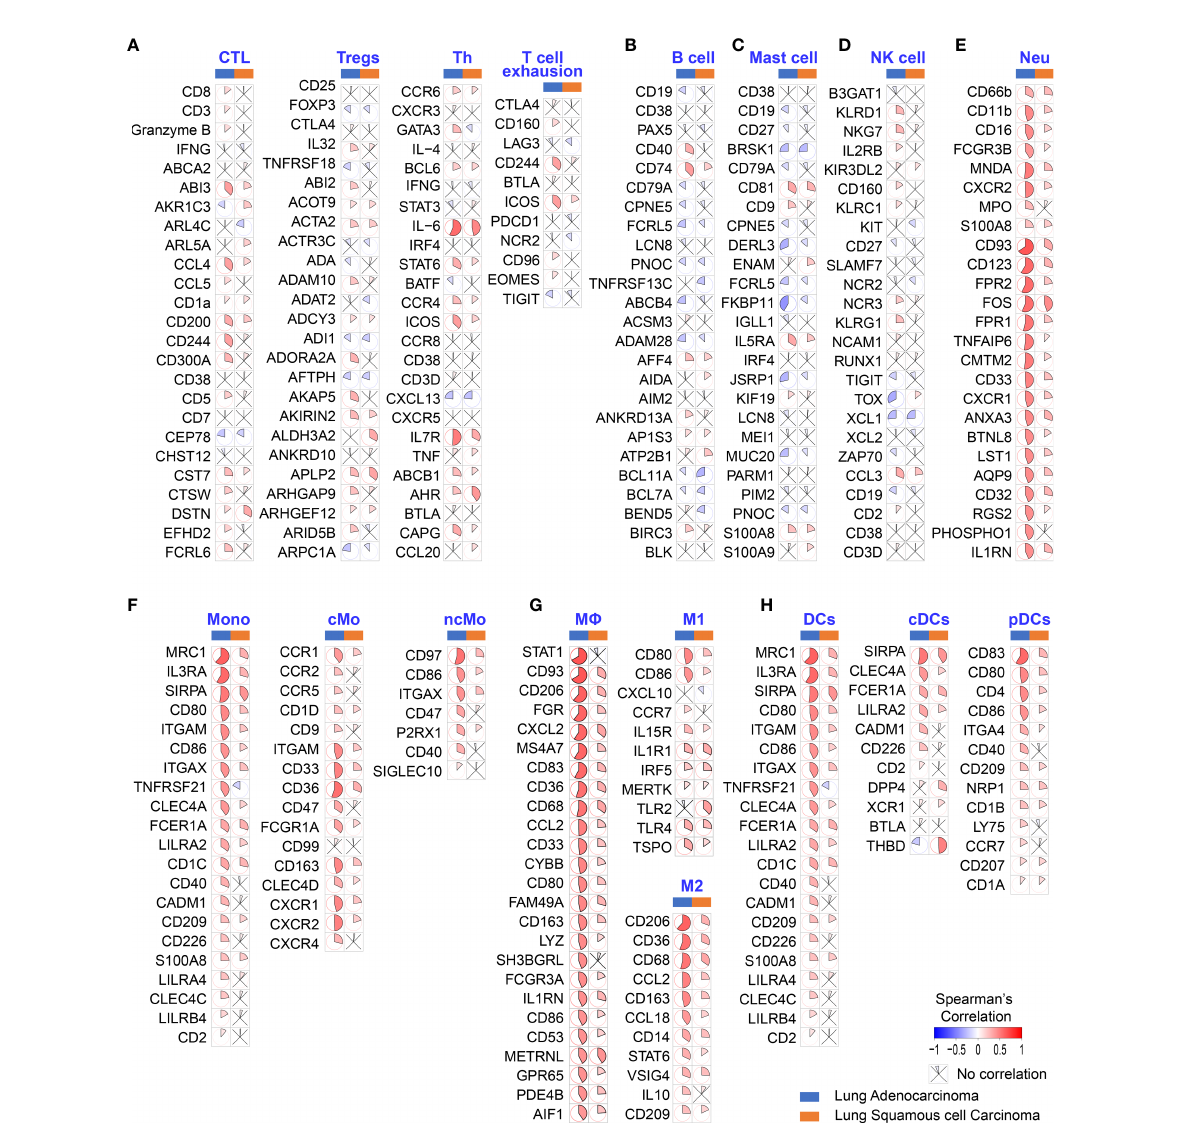
Figure 3), and the lung epithelium (e.g., alveoli and cancer cells), stroma (e.g., endothelial cells and fi broblasts), and immune cells (e.g., T, NK, B, bone marrow and mast cells) were identi fi ed as common cell types. HB-EGF was particularly highly expressed in myeloid and epithelial cells (Figure 3D), suggesting that these cells are the main sources of HB-EGF secretion in the lung TME.